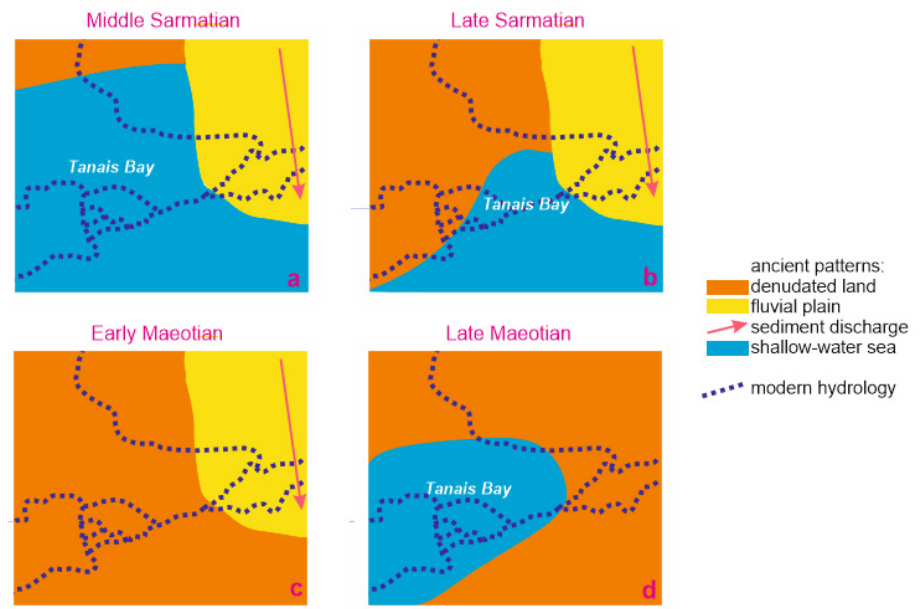
Figure 4. Principal palaeogeographical domains of the Rostov Done in the Middle Sarmatian ( a ), Late Sarmatian ( b ), Early Maeotian ( c ), and Late Maeotian ( d ) (created by the author; modern hydrology is shown to make a link to the present geography outlined on Figure 3).